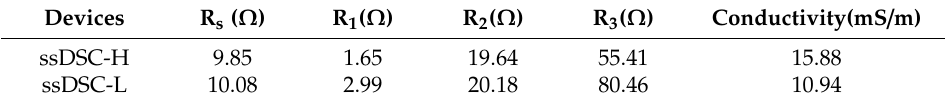
Figure 8. Nyquist plots of EIS spectra for the ssDSCs with PBCzA-H and PBCzA-L, measured at − 0.7 V in the dark. Inset shows the equivalent circuit for ssDSC.